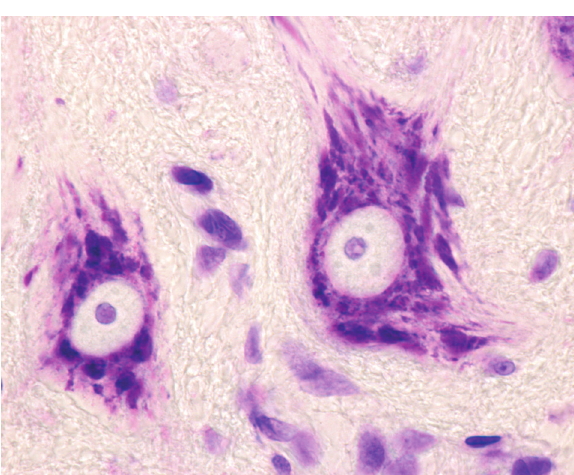
Figure 2. Nissl bodies in motor neurons located in the ventral horn of the spinal cord stained with